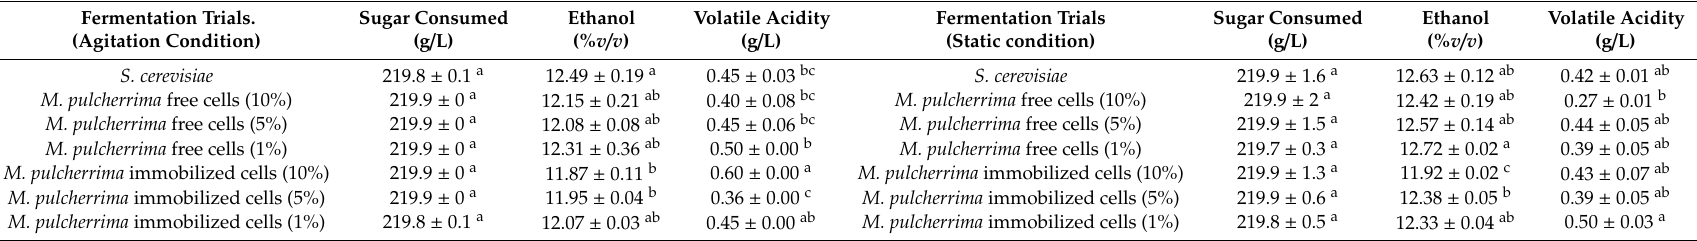
Table 1. Main fermentation parameters of preliminary screening of M. pulcherrima in sequential fermentation trials with S. cerevisiae EC1118 inoculated after 72 h of fermentation in SGJ.